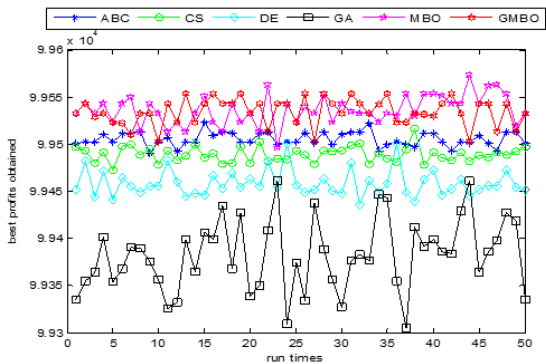
Figure 12. Comparison of the best values on KP15 in 50 runs.